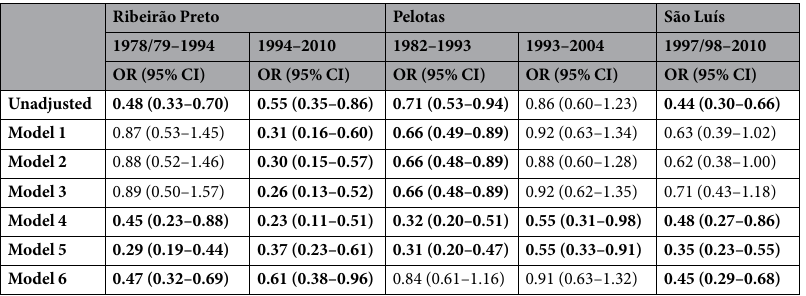
Table 2. Hierarchical analysis of the association between year and neonatal mortality in Ribeirão Preto (1978/79, 1994 and 2010), Pelotas (1982, 1993 and 2004) ad São Luís (1997/98 and 2010). OR: Odds ratio; CI: Confidence Interval. Values highlighted are those with significant statistical results. Model 1: Adjusted for sociodemographic characteristics ; Model 2: Adjusted for sociodemographic + maternal and gestational characteristics ; Model 3: Adjusted for sociodemographic + maternal and gestational + health care characteristics; Model 4: Adjusted for sociodemographic + maternal and gestational + health care and newborn characteristics; Model 5: Adjusted for gestational age ; Model 6: Adjusted for intrauterine growth